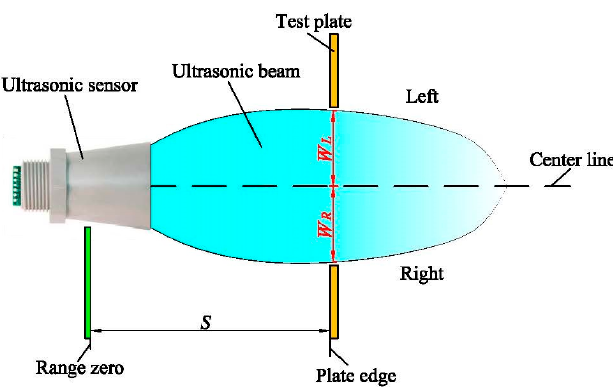
Figure 3. Diagram of measuring method for the beam width of an ultrasonic sensor.